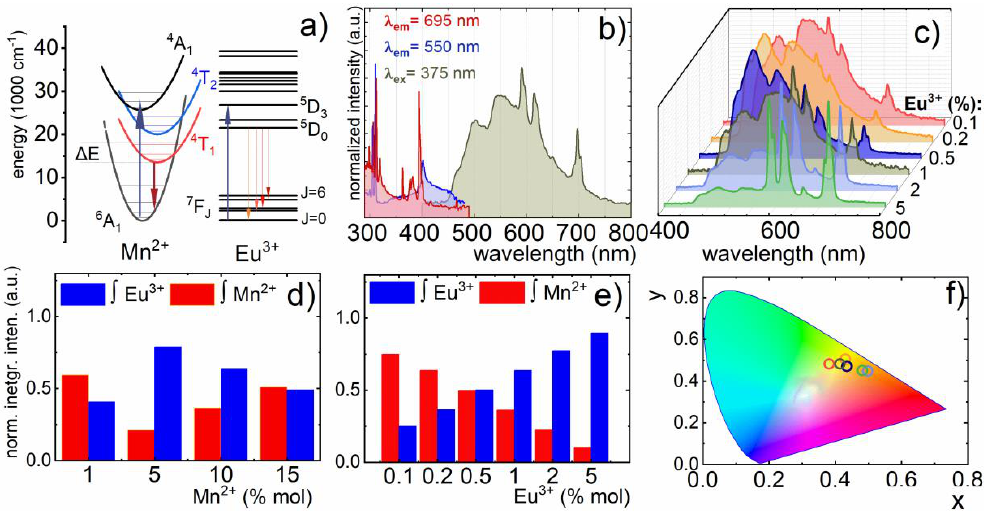
Figure 2. Schematic energy level diagram of Mn 2+ and Eu 3+ ions ( a ); the comparison of the excitation spectra for λ em = 550 nm and λ em = 695 nm and emission spectra λ ex = 375 nm measured at 30 °C of GdPO 4 : 10%Mn 2+ , 1%Eu 3+ nanoparticles ( b ); the comparison of the emission spectra of GdPO 4 with 0.2, 0.5, 1, 2, and 5% Eu 3+ and 10%Mn 2+ concentration measured upon 375 nm excitation ( c ); contribution of the particular ion’s emission intensity to the total emission spectra for different Mn 2+ ( d ) and Eu 3+ ( e ) concentrations at 30 °C; and the CIE diagram for GdPO 4 : 10% Mn 2+ , x% Eu 3+ (x=0.1, 0.2, 0.5, 1, 2, 5%) (f).